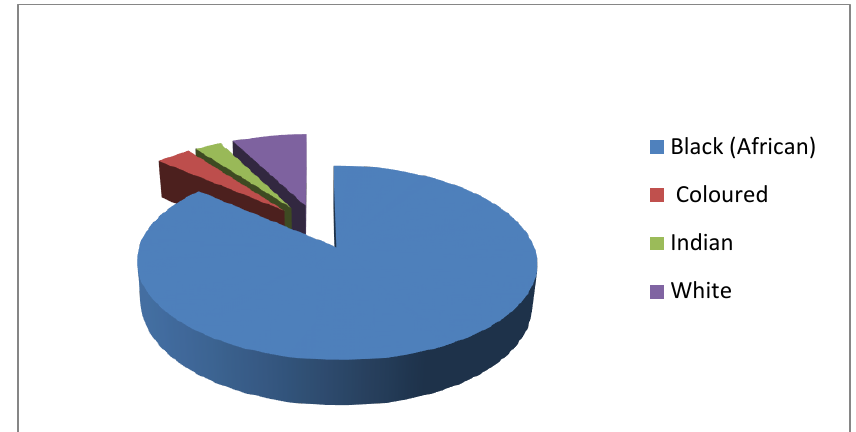
Figure 3. Composition of the race